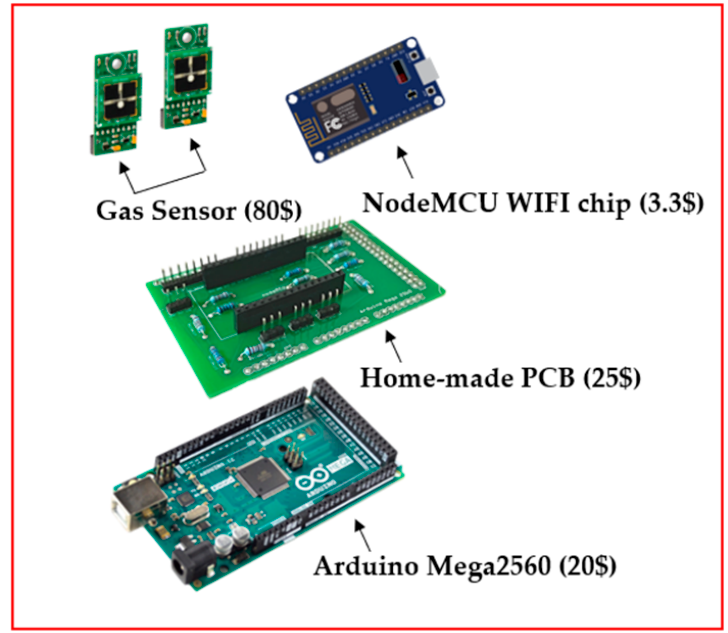
Figure 1. Component assembly diagram of IoT device.